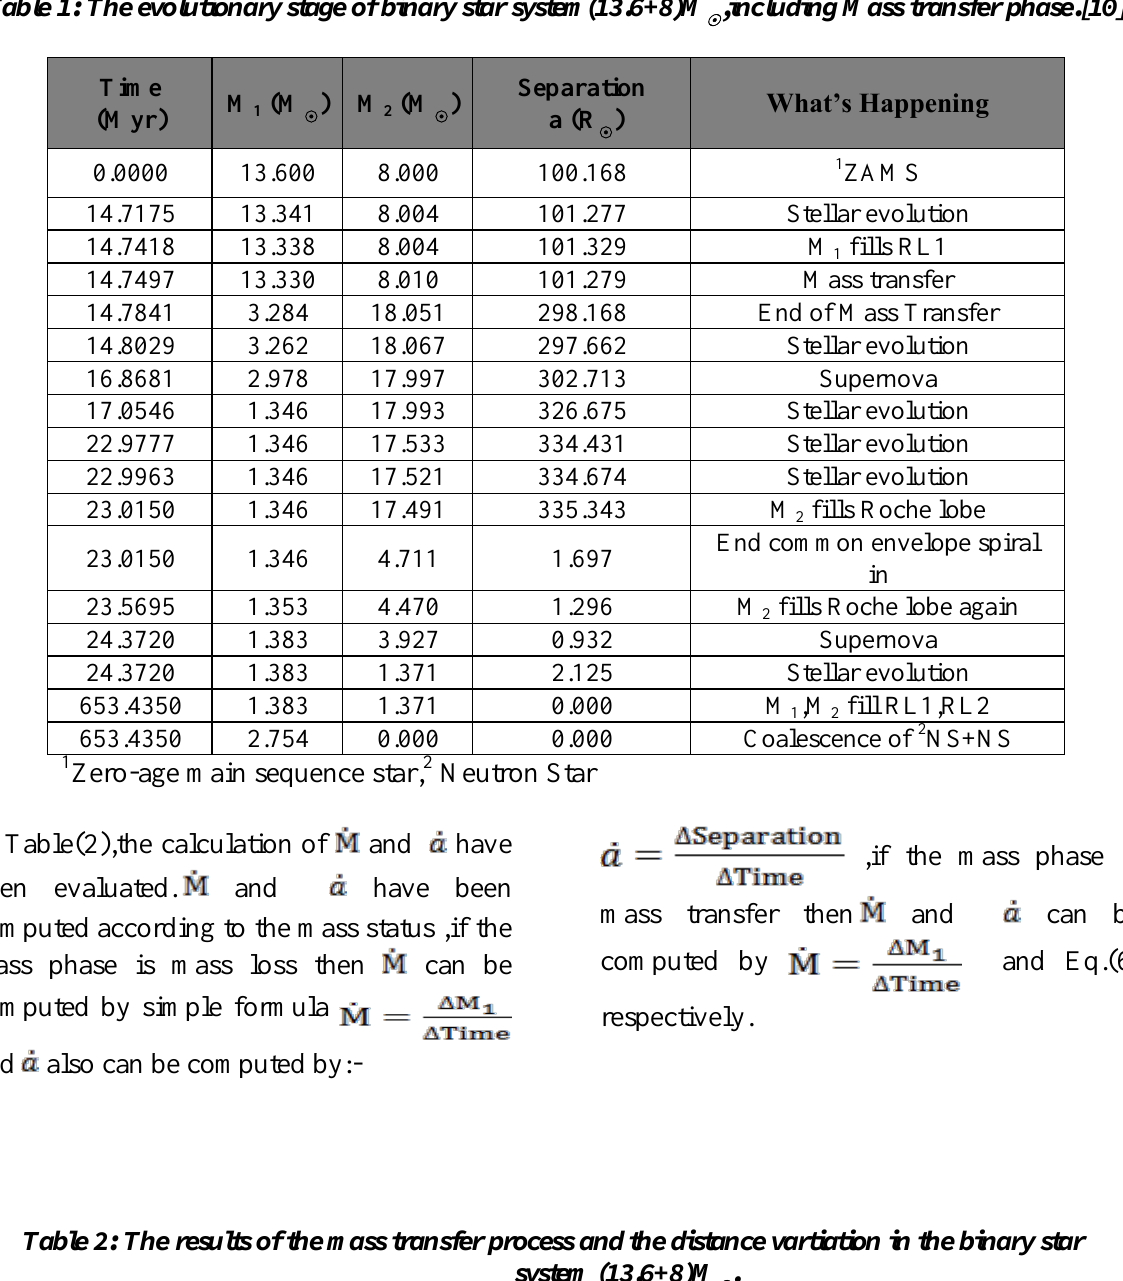
,including Mass transfer phase.[10] 